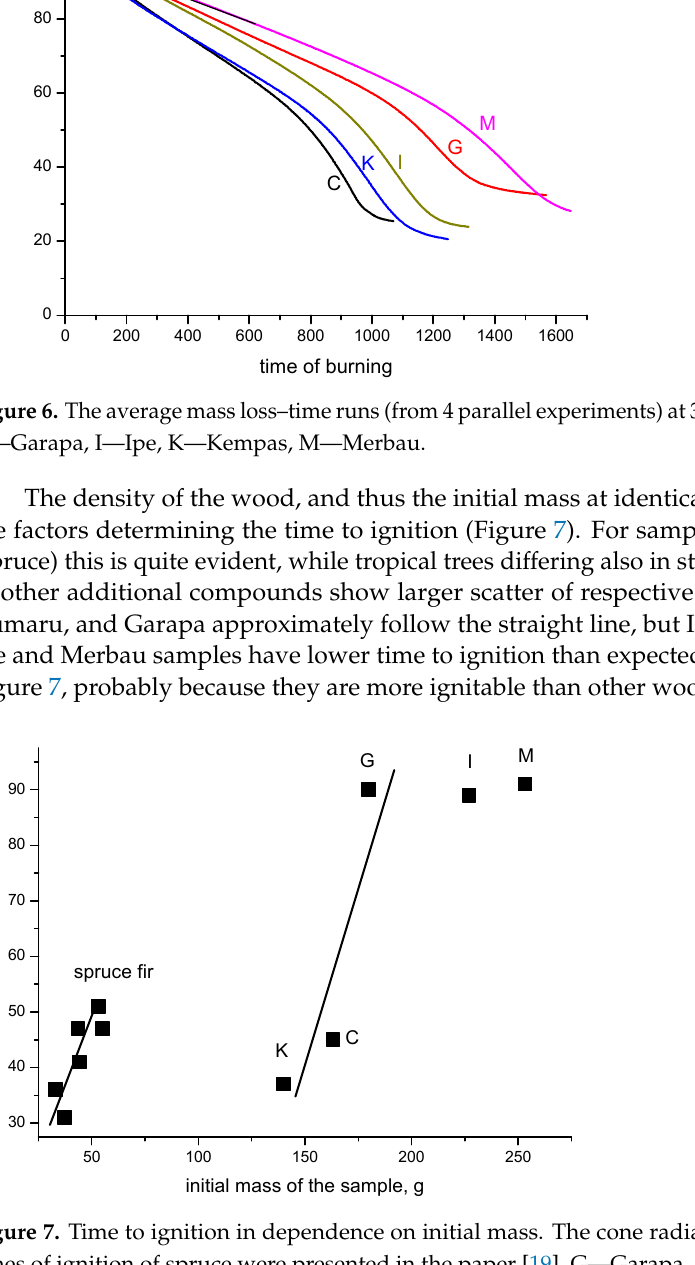
Figure 7. Time to ignition in dependence on initial mass. The cone radiancy was 35 kW/m 2 . The times of ignition of spruce were presented in the paper [19], G—Garapa, C—Cumaru, K—Kempas, I—Ipe and M—Merbau.